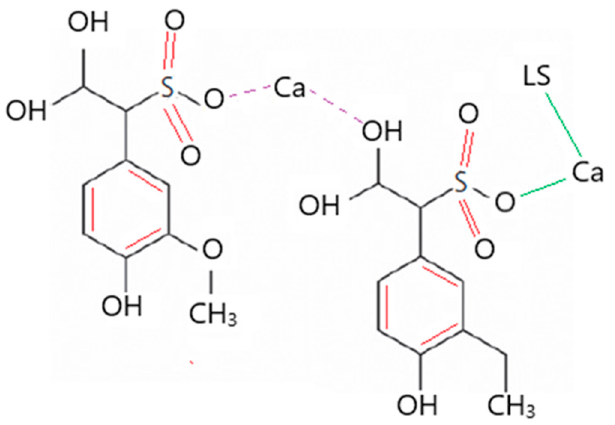
Figure 2. Chemical structure of